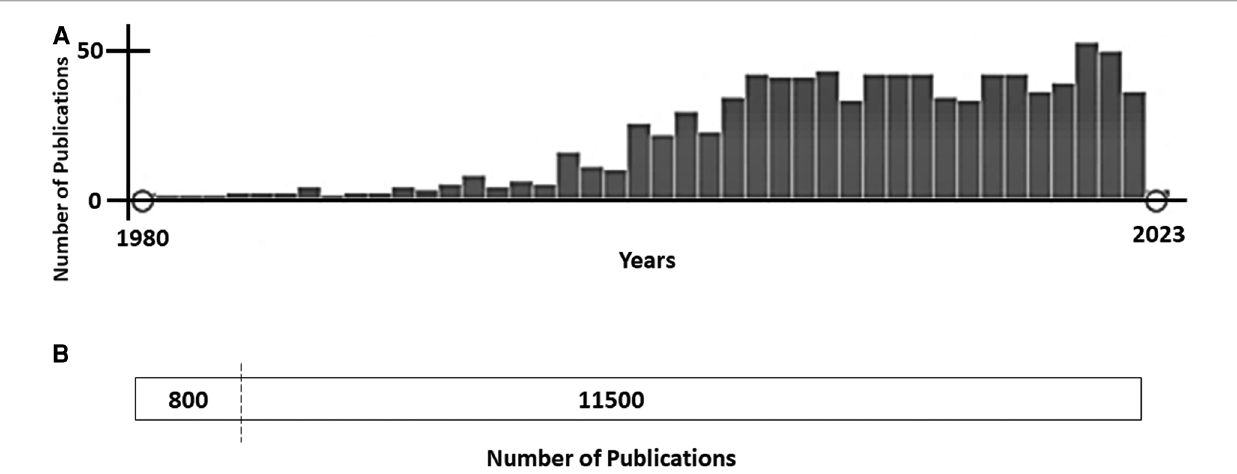
FIGURE 1 ( A )- publications focused on long QT syndrome (pubMed, January 2023). From approximately 11,500 publications about Long QT Syndrome, less than 10% (800 publications) included any data concerning females/women or gender/sex differences. ( B )- Time-line of publications focused on Long QT Syndrome and sex differences (PubMed, January 2023). Since 2005, the number of publications including any data concerning gender/sex differences has been maintained at nearly 45 – 50 studies per